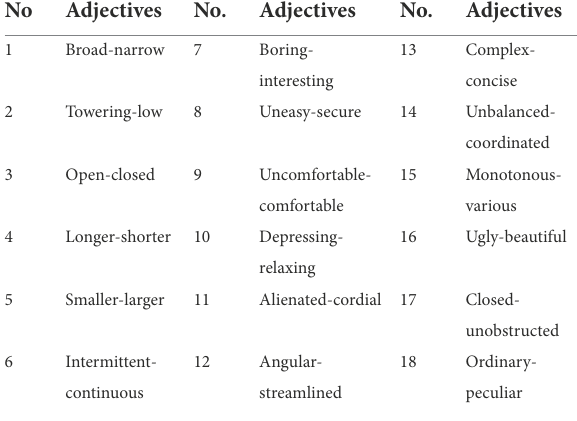
TABLE 5 Collection of cognitive adjective pairs in space.